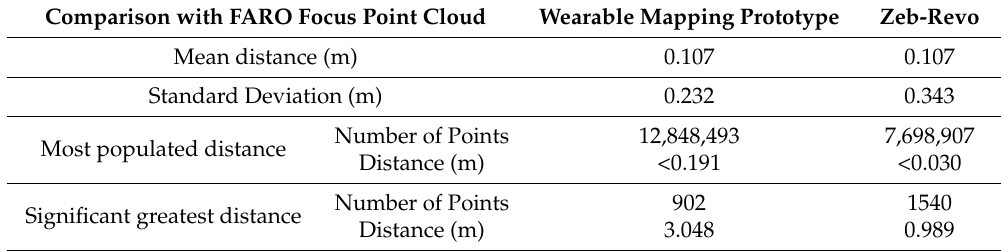
Table 11. Point-cloud to point-cloud distance between the Wearable Mapping Prototype, the Zeb-Revo and the FARO Focus, for Case study 2.